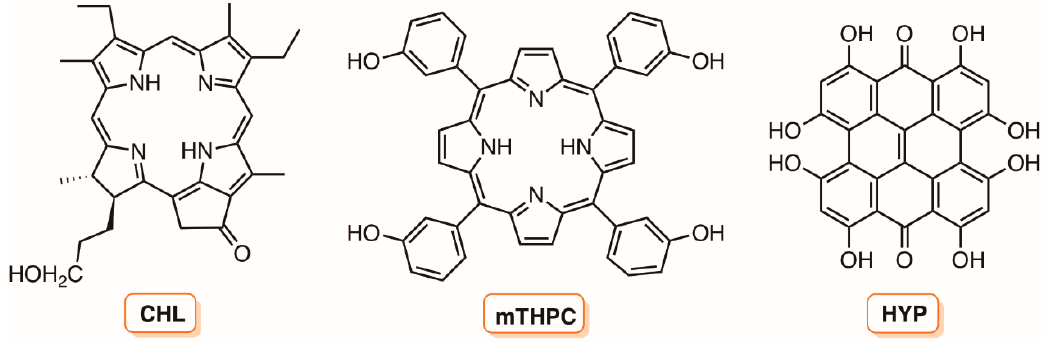
Figure 34. Structures of PS used after incorporation in liposomes formulations to efficiently photoinactivate bacteria and viruses.